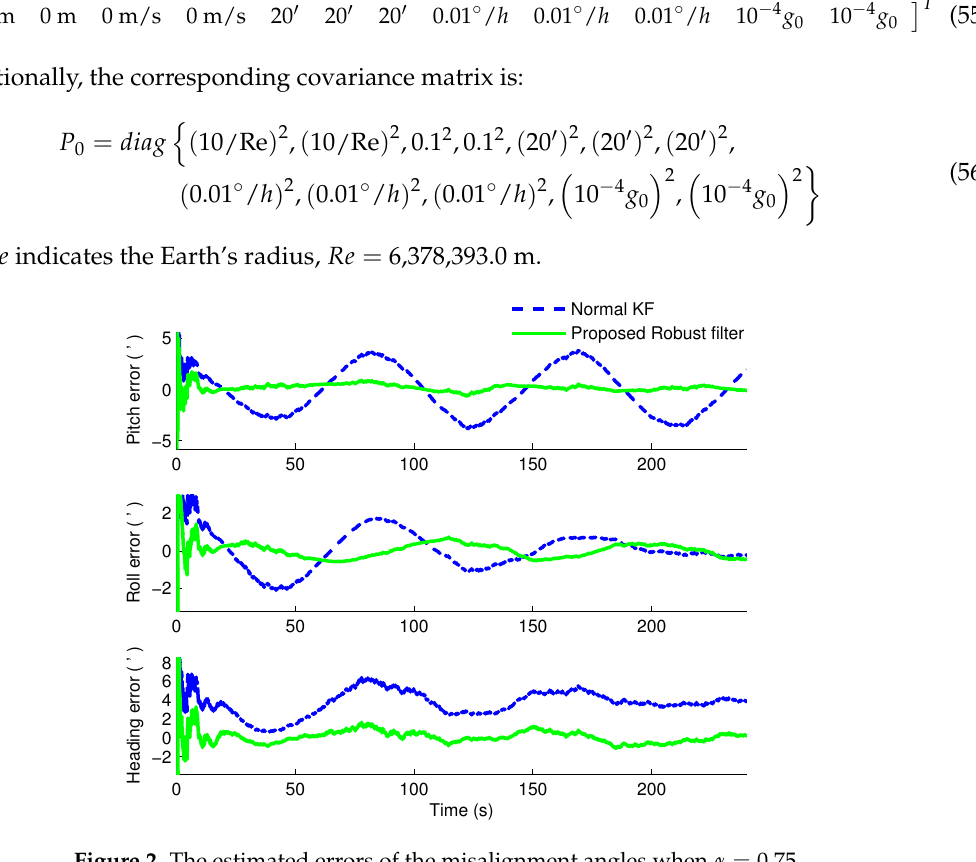
Figure 2. The estimated errors of the misalignment angles when α =